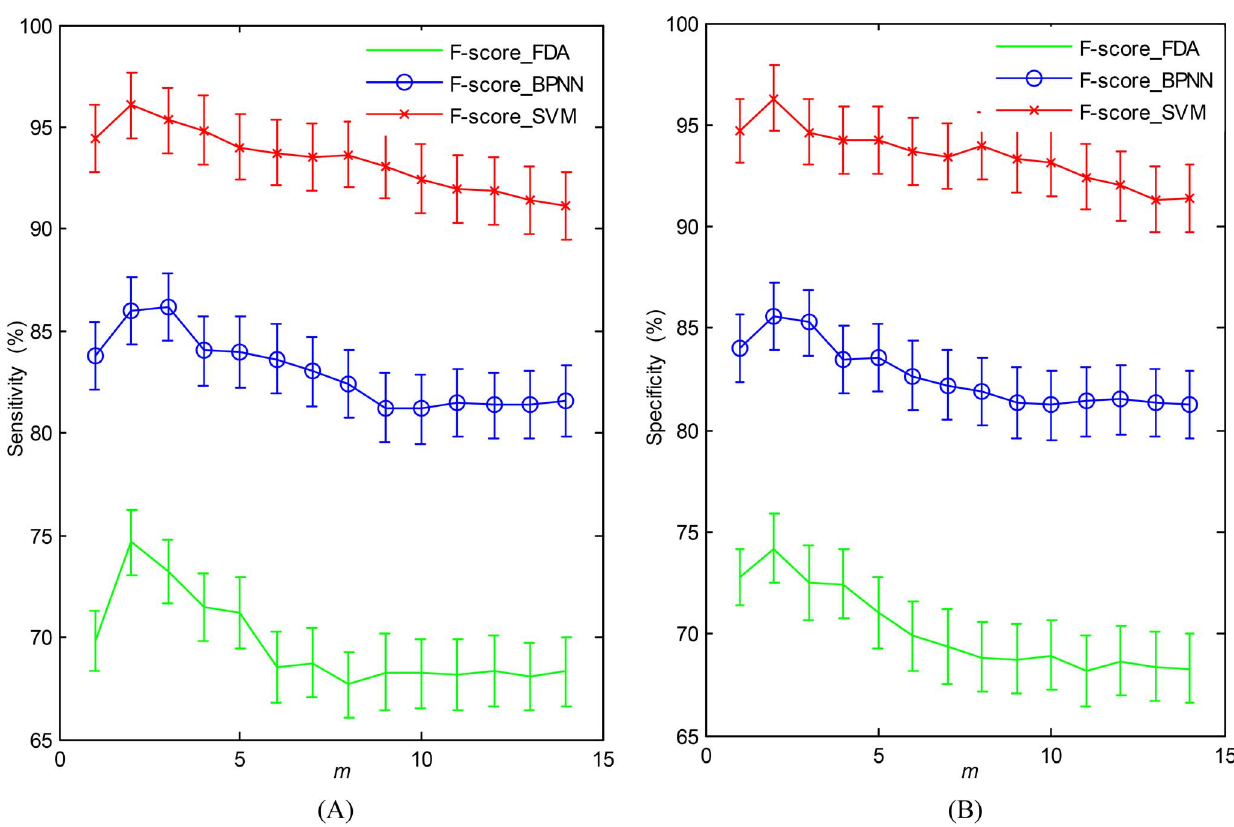
Figure 9. The accuracy (mean + SD) of classifying P300 (sensitivity) and non-P300 (specificity) for three classification models with different parameter value m on training sets (when k1= 0.85, k2= 0.70 and k3 =0.40). 9A: Sensitivity for the training sets. 9B: Specificity for the training sets.